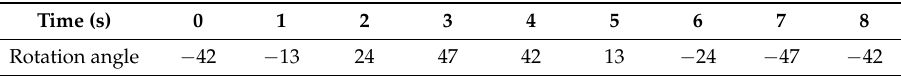
Table 3. Position of the Module 1 servo at each time 1